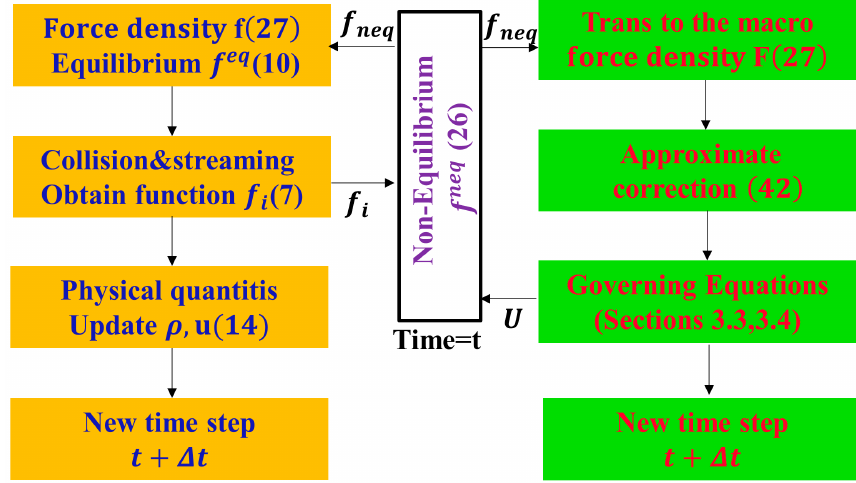
Figure 2. Flow chart of coupling algorithm via non-equilibrium-IB-LBM.